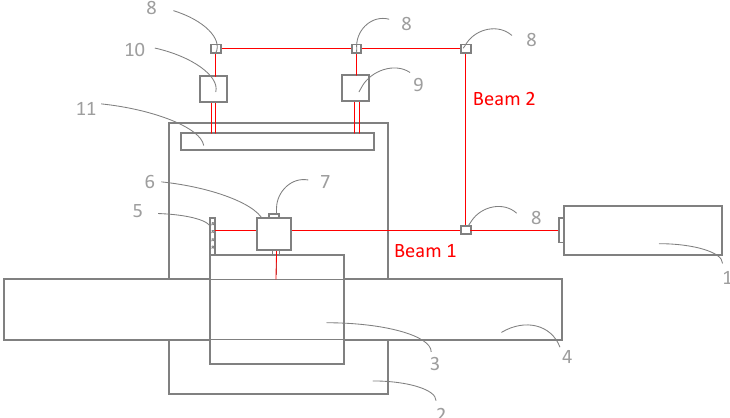
Figure 14. Optical path diagram of measuring system. 1. Laser; 2. inner carriage; 3. slider; 4. quartz guide rail; 5. ground glass; 6. interferometer A; 7. tool system; 8. beam splitter; 9. interferometer B; 10. interferometer C; 11. measuring mirror.